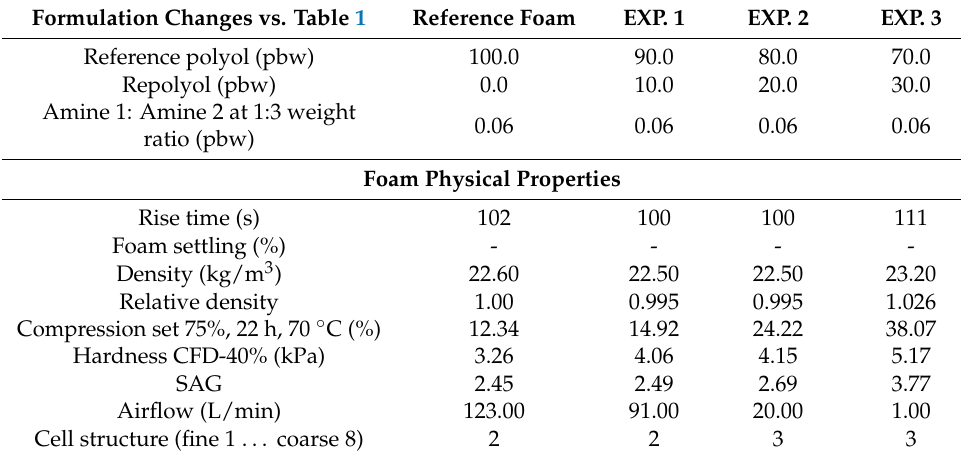
Table 4. The influence of the gradual substitution of the reference polyol with Repolyol on the properties of the flexible PU